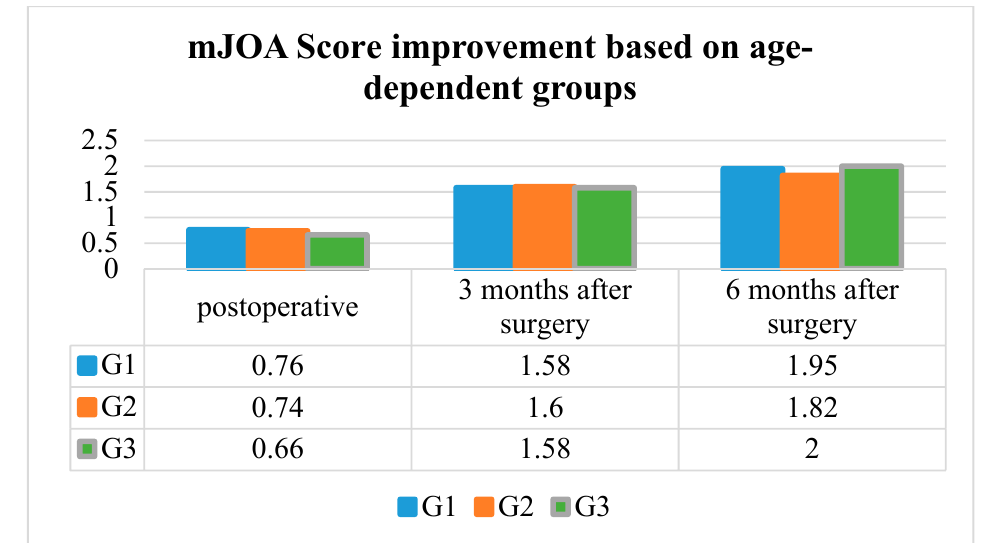
Figure 4. mJOA Score improvement based on the age-dependent groups.